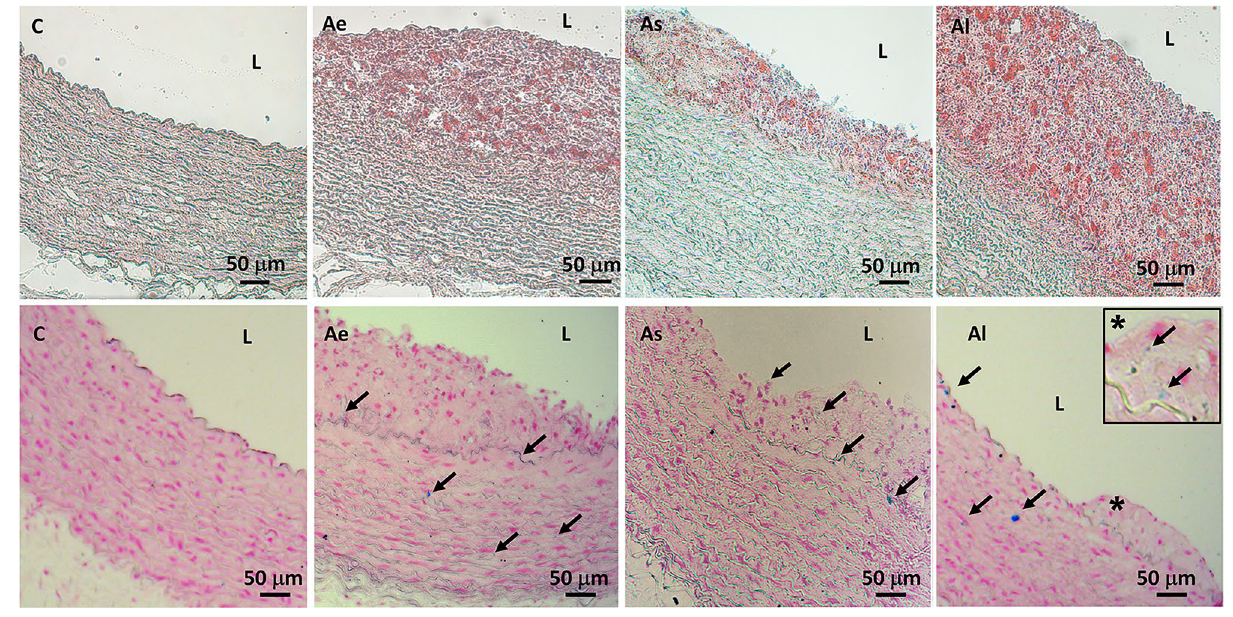
Figure 3. Representative histopathological staining of the ascending aortic segments, embedded in OCT and frozen in liquid nitrogen . The upper panel was obtained after double staining with Oil Red O and Hematoxylin of the serial sections, for lipid deposits’ detection. The lower panel sections were stained with Prussian Blue and Nuclear Fast Red solutions to evidence ferrous and ferric iron in blue, the cytoplasm in pink and cell nuclei in red. C: control group, Ae: early atherosclerotic group, As: statin and PCSK9 antibody stabilized atherosclerotic group and Al: late atherosclerotic group (see also the inset for higher magnification, ×